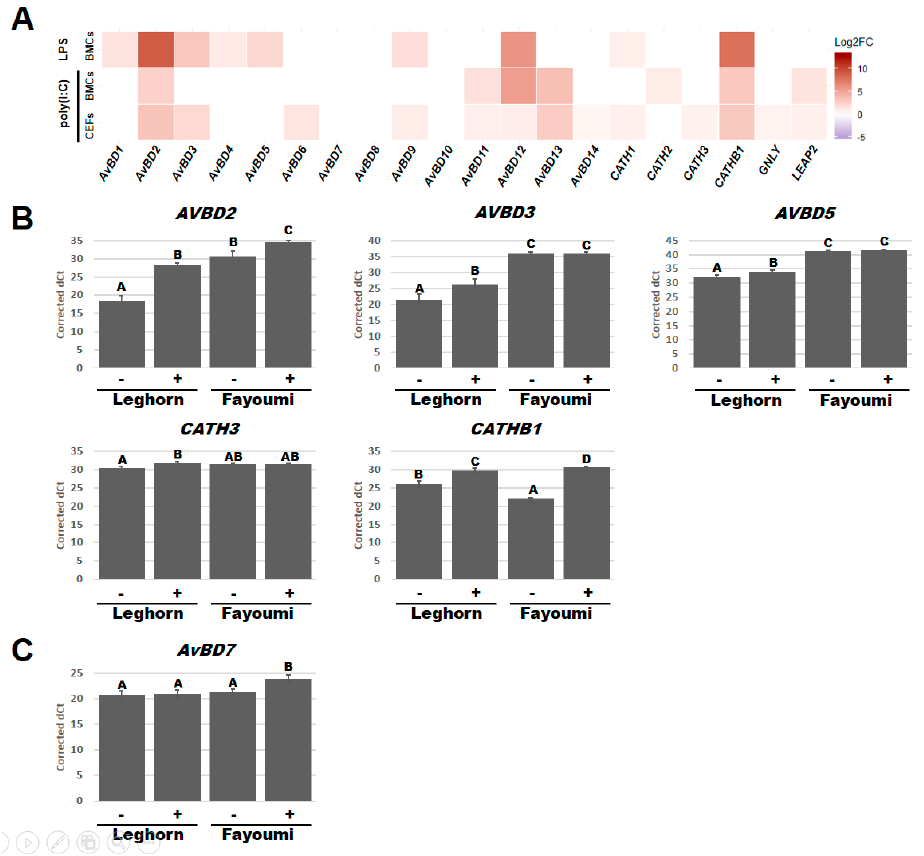
Figure 3. Host defense peptides (HDPs) that responded to LPS or poly(I:C) treatment. Heatmap for Log 2 fold change (Log2FC) of each HDPs comparing the LPS- or poly(I:C)-treated cells to the non-treated or non-poly(I:C)-treated cells in BMCs or CEFs ( A ). Bar graph of corrected dCts for HDPs with a significant interaction between line and LPS in BMCs ( B ) and between line and poly(I:C) in CEFs ( C ). Corrected dCts were calculated by 30 (maximum detected dCt)—lsmean of the targeted gene dCt and LSmeans adjusted according to each linear model. BMCs, bone marrow-derived cells; CEFs, chicken embryonic fibroblasts; -, with treatment; + , without treatment. Statistical significance was indicated as a di ff erent character above each bar in